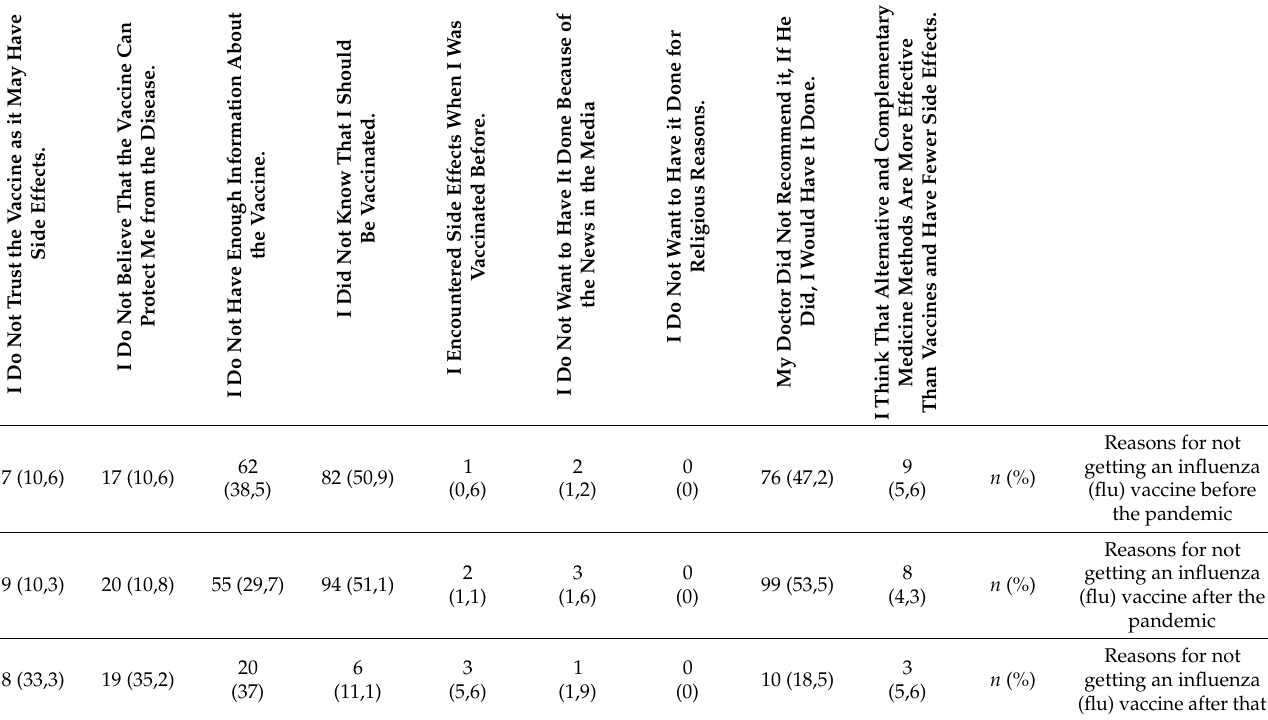
Table 4. The reasons for not getting